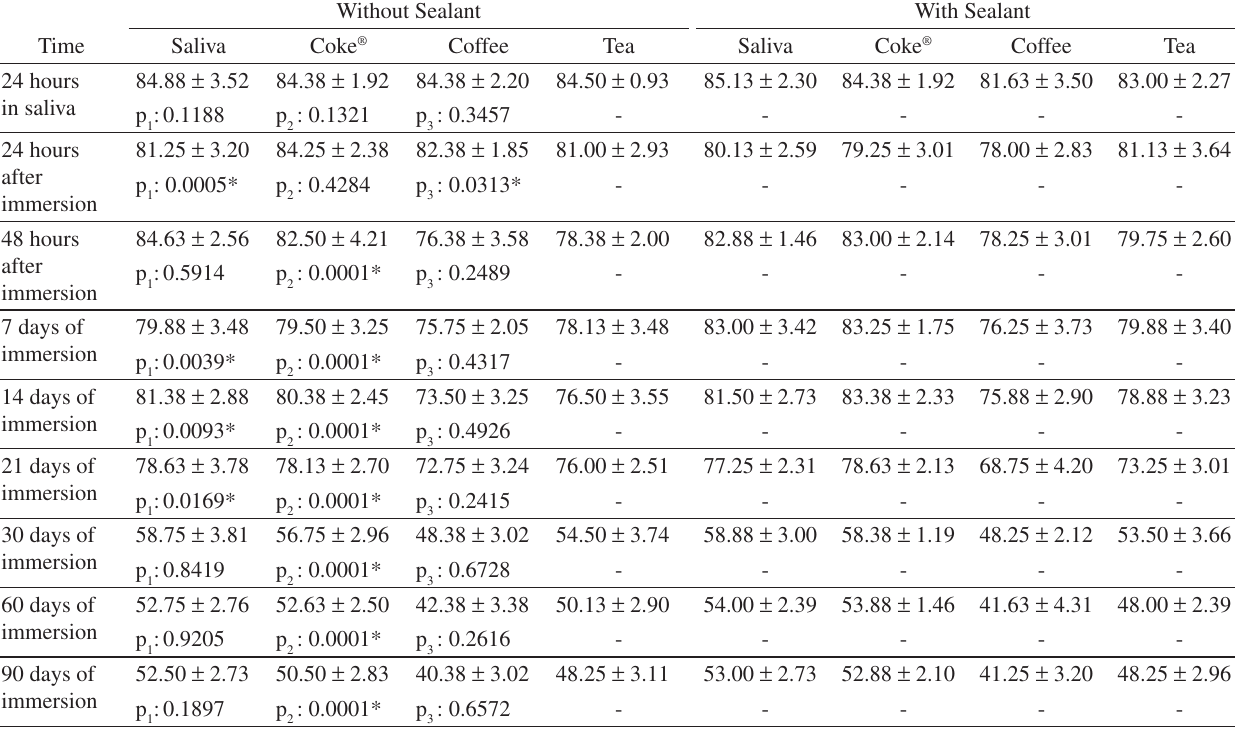
Table 1. Translucency (%) mean and standard deviation for composite resin and p-value (p ANOVA.